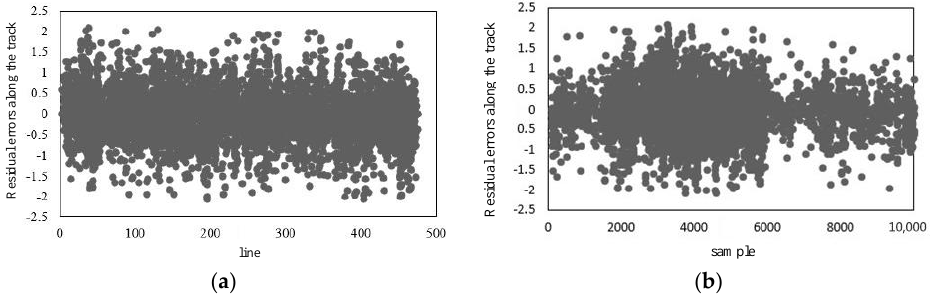
Figure 8. Residual errors after the calibration of the temporal system parameters: ( a ) Residual errors along the track (flight direction); ( b ) residual errors across the track (flight direction). Figure 9 is the distribution of residual errors after the calibration of the whiskbroom angle parameters. As shown in Figure 9 and Table 2, the residuals after the calibration of the whiskbroom angle parameters across the track are reduced to less than 2.5 pixels. Meanwhile, as seen from the contrast with Figure 7b,d, on the one hand, the residuals across the track no longer show local regularity and their distribution is uniform globally, and on the other hand, as shown in Figure 9a, there is still, on the whole, obvious errors in the vertical coordinates along the track, taking on a trend of “two large ends, a small middle”.